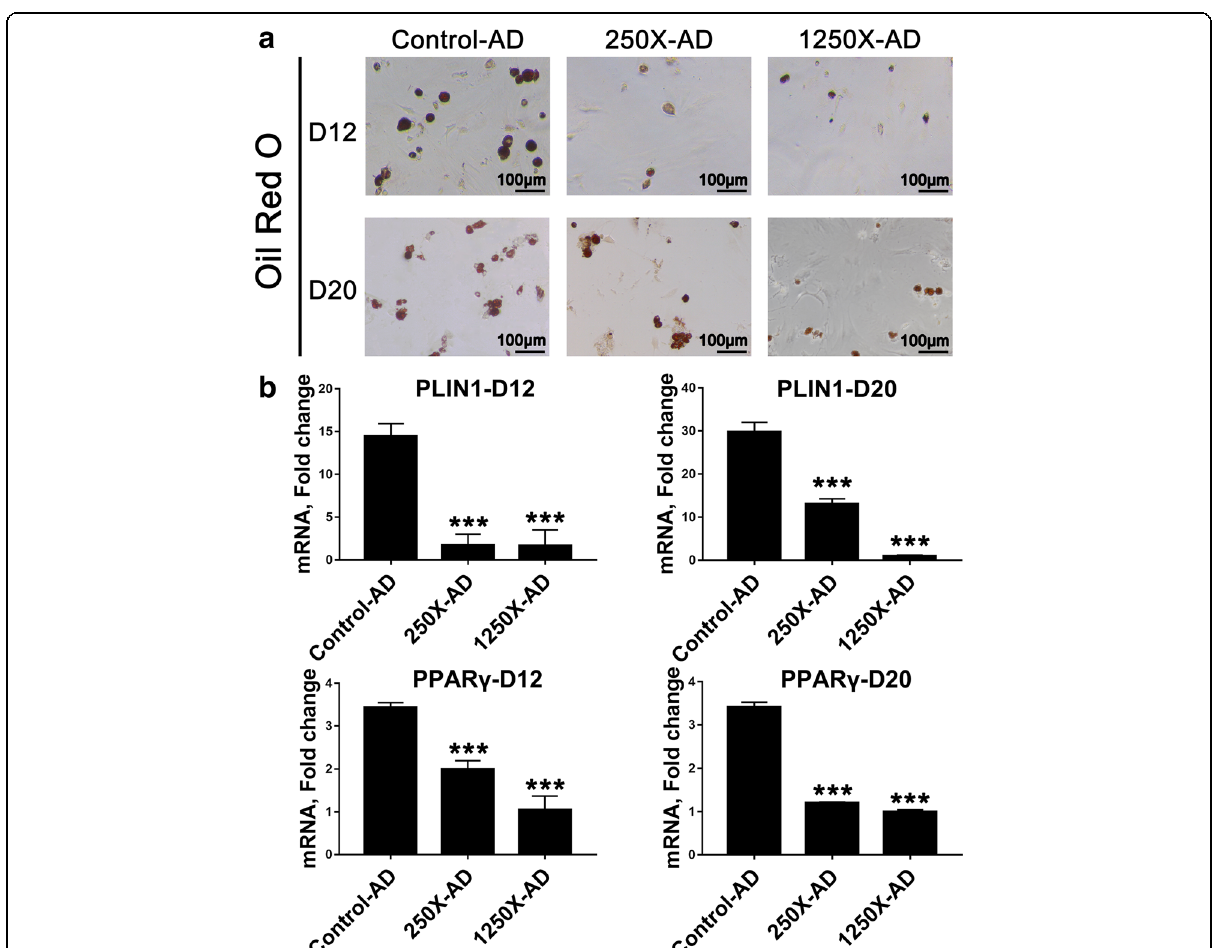
Fig. 5 Effect of different concentrations of Osteoking on adipogenic differentiation potential of rbMSCs a Oil Red O staining of rat bone marrow mesenchymal stem cells (rbMSCs) cultured in adipose medium with different concentrations of Osteoking after 12 days and 20 days. D = day, X = dilution multiple of Osteoking. b Gene expression analysis for key adipogenic markers by qRT-PCR. *** p < 0.001 vs. Control; n =